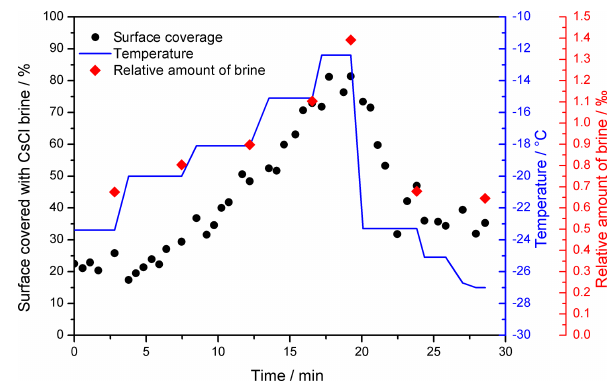
Figure 4. The relative brine surface coverage in the frozen seeded droplet (c(CsCl) = 0.005M) at varying temperatures. The represen- tative images used for the calculation are displayed in Fig. 3. The temperature of the cooling stage during the measurement is indi- cated with the blue pattern. The red diamonds denote the relative amount of brine in the frozen sample, based on the phase diagram (Fig. 1); temperatures 2 ◦ C higher than those of the cooling stage were used for the calculation to better represent the sample temper- ature.